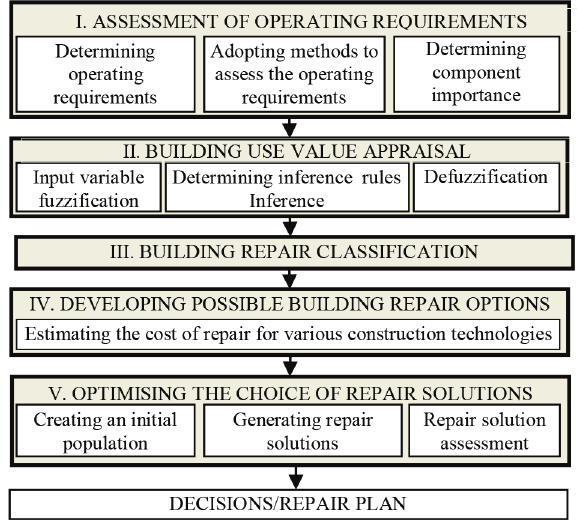
Fig. 1. Decision-making model